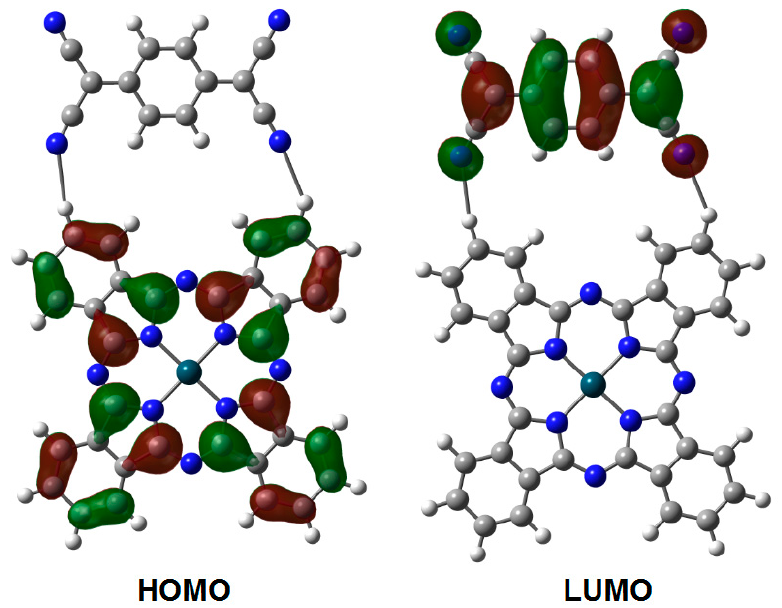
Figure 5. Frontier molecular orbitals of the cobalt(II) phtalocyanine complex.